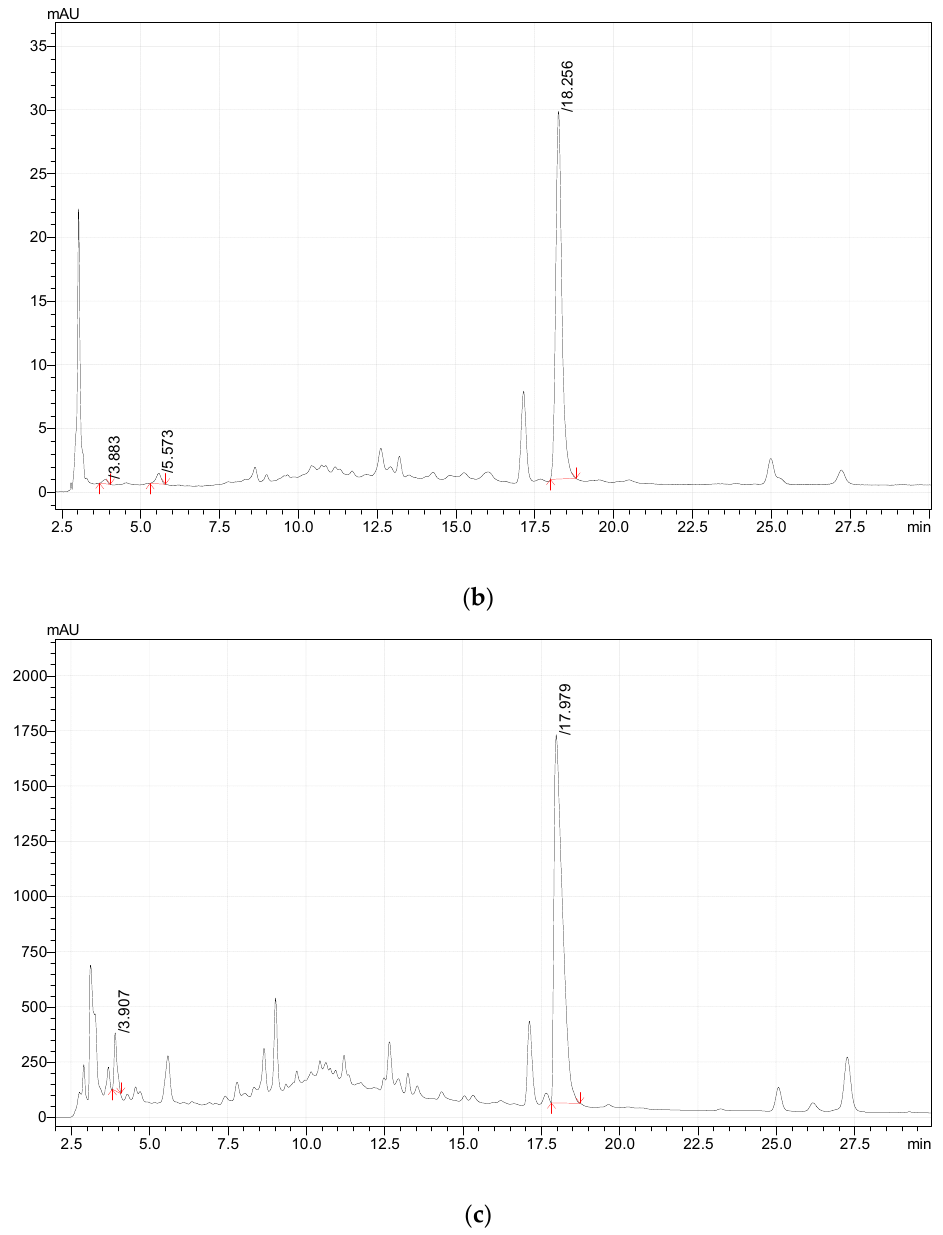
Figure 2. HPLC chromatogram of ( a ) ethyl acetate, ( b ) methanol (1/100 dilution), and ( c ) water extracts of A. glutinosa (cones).